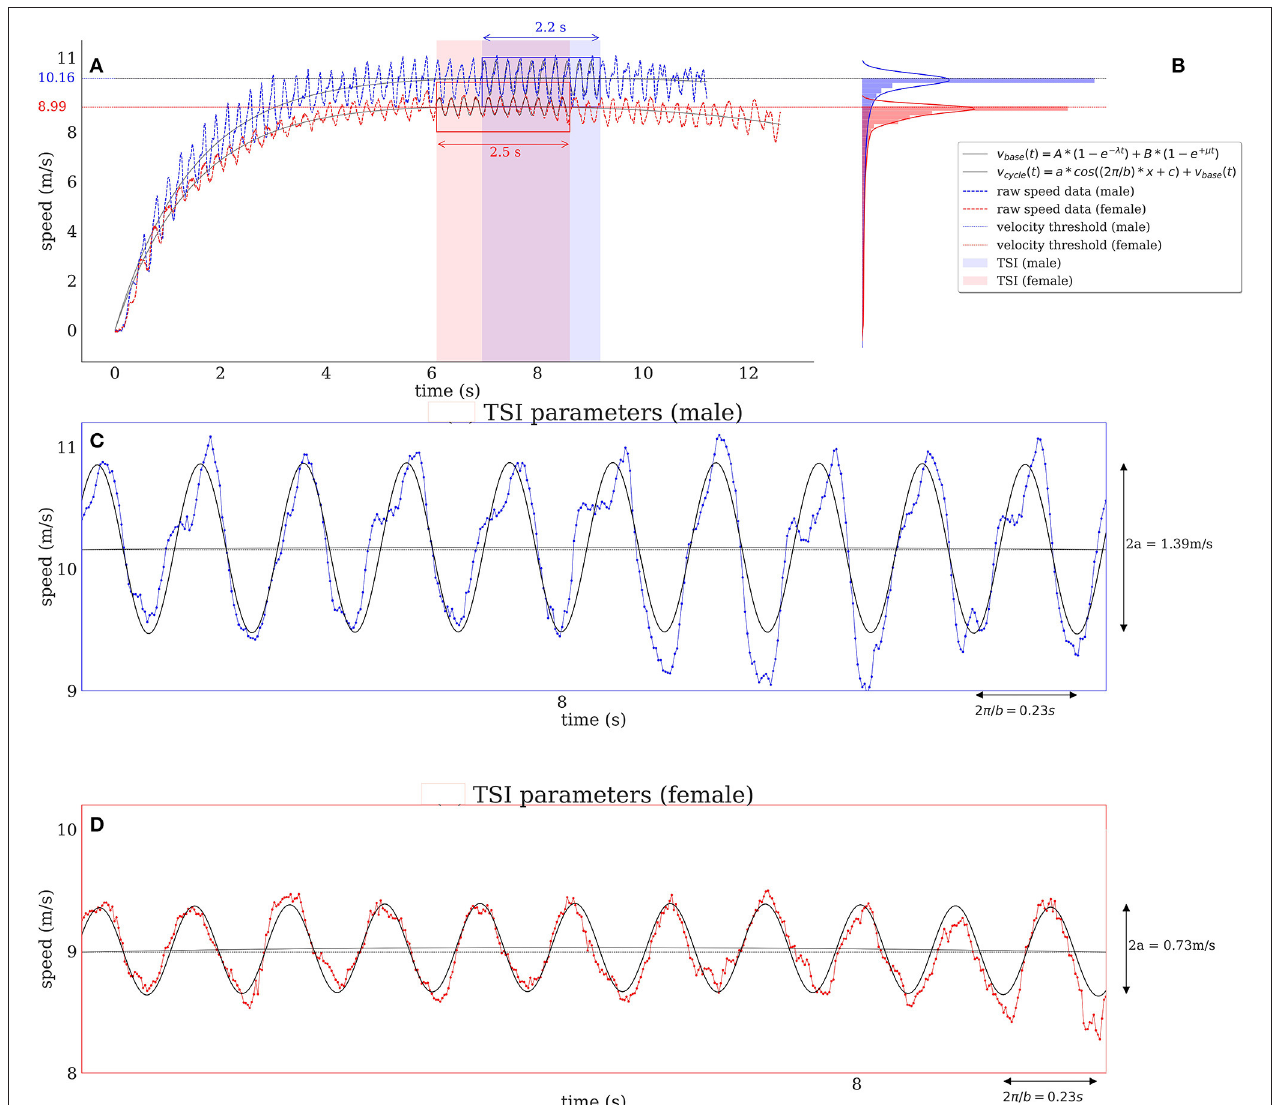
FIGURE 3 | Comparison for two runs performed by female (red) and male (blue) athletes. Panel (A) shows raw speed (dotted line) and fitted v base ( t ) which allows to estimate TSI start and end time for each run individually by estimating a run-specific speed threshold based on the observed speed distribution (B) . Zoomed views of TSI are shown for a male (C) and a female runner (D) . Within TSI we obtain TSI step time (which is the same for both runners − 0.23s) and TSI amplitude which is larger for the male runner (1.39 vs. 0.73